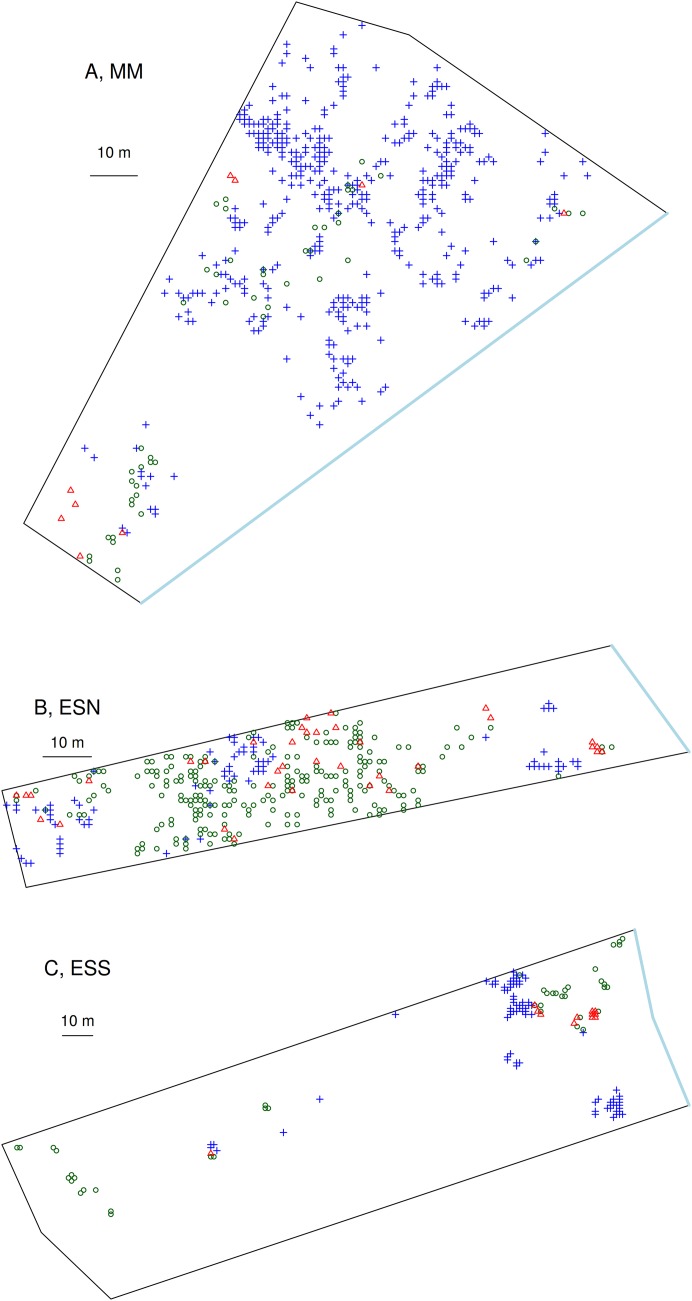
Fine scale distribution of C. aspera (2x), C. seridis (4x), and C. x subdecurrens (3x) in the three studied sampling plots.C. aspera (2x): green circles, C. seridis (4x): blue crosses, and C. x subdecurrens (3x): red triangles. Study sites: (A) MM, Marjal dels Moros; (B) ESN, El Saler North; (C) ESS, El Saler South. The blue line represents the edge of the sea.